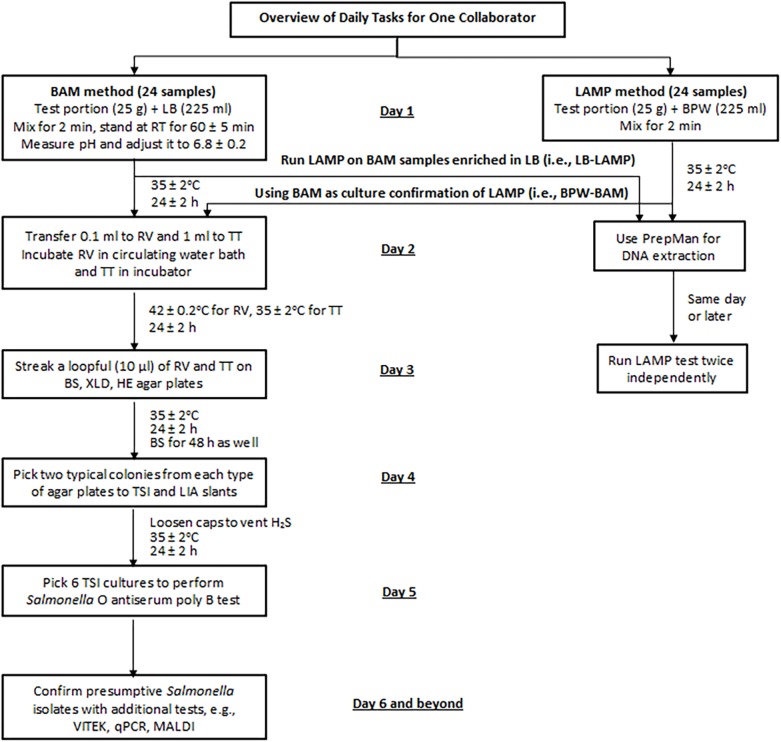
Sample analysis flowchart for the MLV study. LB, lactose broth; BPW, buffered peptone water; RV, Rappaport-Vassiliadis medium; TT, tetrathionate broth; BS, bismuth sulfite agar; XLD, xylose lysine desoxycholate agar; HE, Hektoen enteric agar; TSI, triple sugar iron agar; LIA, lysine iron agar; qPCR, real-time quantitative PCR; MALDI, Matrix Assisted Laser Desorption Ionization.